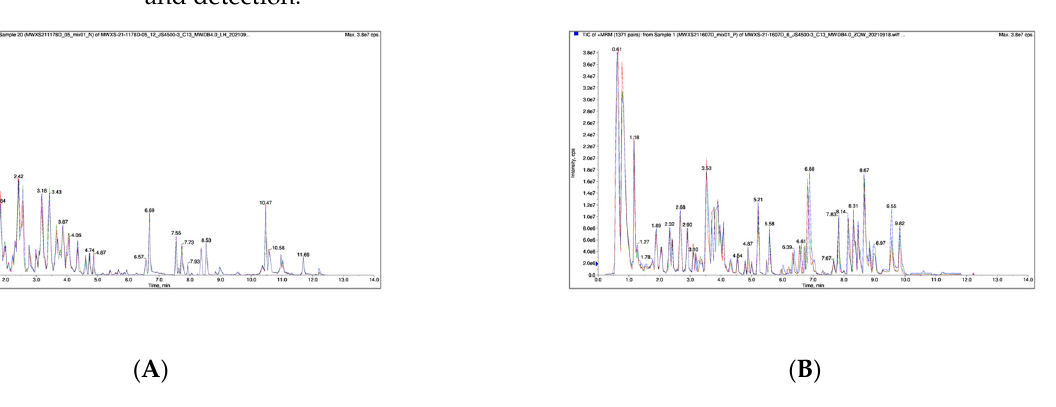
Figure 1. TIC overlapping figures of different QC samples (different colors represent different QC samples). ( A ) Negative ion mode. ( B ) Positive ion mode.